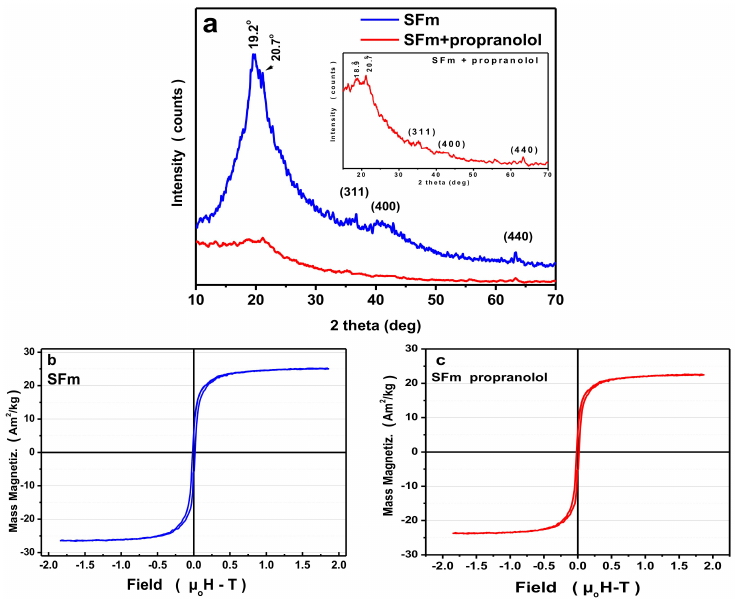
Figure 6. ( a ) XRD patterns of the magnetic silk fibroin nanoparticles and the propranolol-encapsulated magnetic silk fibroin nanoparticles; ( b ) hysteresis loop of the magnetic silk fibroin nanoparticles; and ( c ) hysteresis loop of the propranolol-encapsulated magnetic silk fibroin nanoparticles. FTIR results of silk fibroin-bovine serum albumin nanoparticles and propranolol-encapsulated silk fibroin-bovine serum albumin nanoparticles are presented in Figure 7a,b, respectively, and